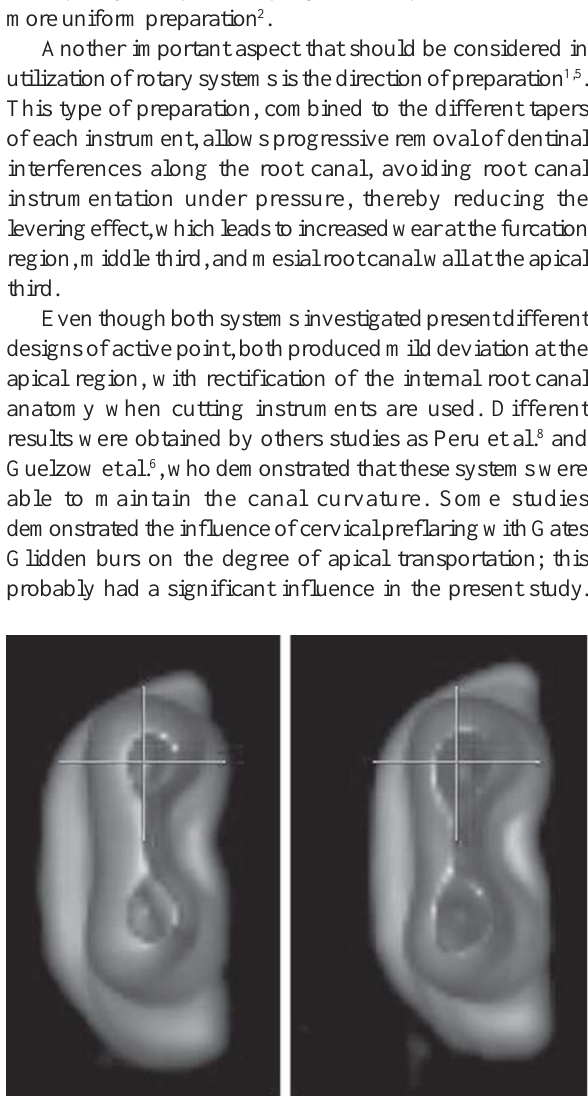
FIGURE 2- Radiographic image for measurement of apical deviation